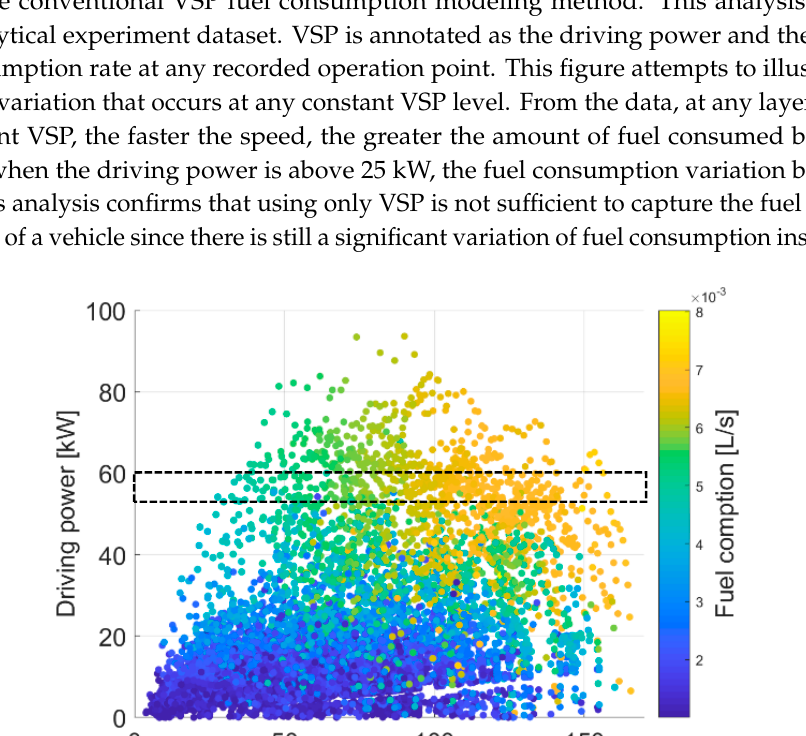
Figure 2. Real-world experiment routes’ orientations and locations [20].